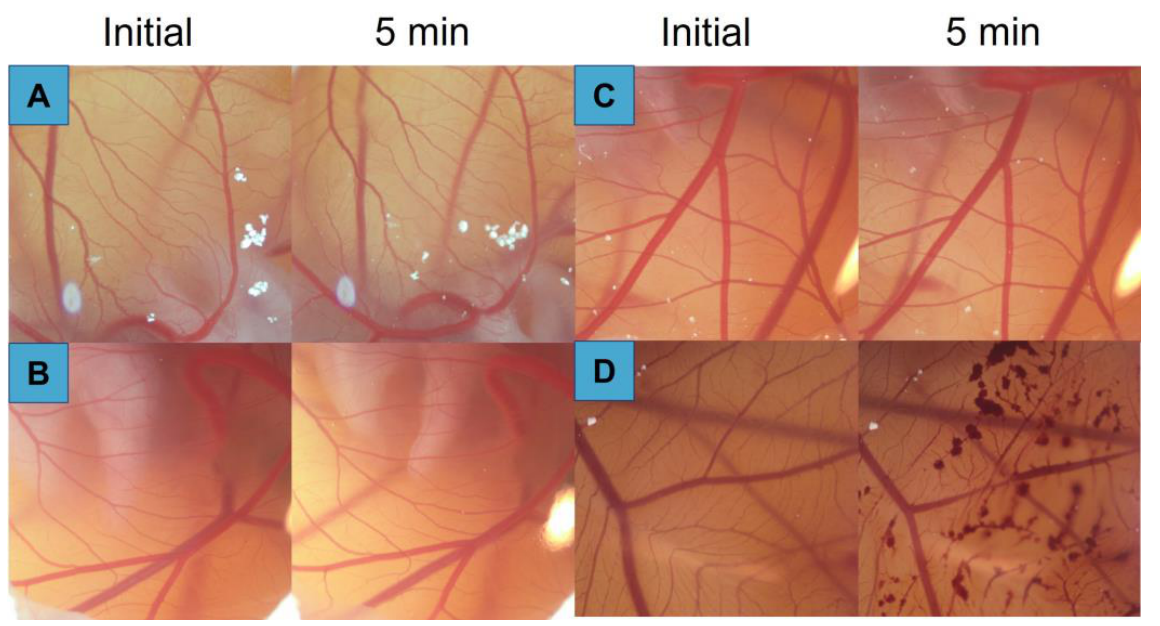
Figure 11. 5 min post-instillation images of Hen´s egg test on the chorioallantoic membrane (HET-CAM) for different natamycin/voriconazole formulations. ( A ) SNV; ( B ) AHNV; ( C ) LNV; ( D ) NaOH 0.1 M.